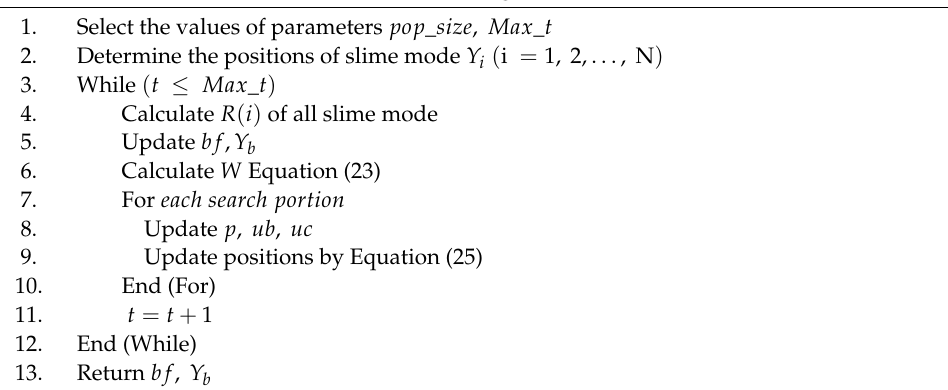
Figure 1. Flowchart of the SMA. Algorithm 1. Pseudo-code of the Slime Mould Algorithm